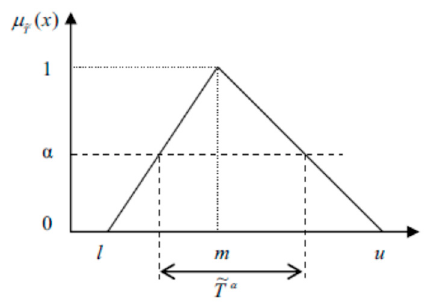
Figure 3. α -cut of a triangular fuzzy number (cid:101) T (Source: [45]).